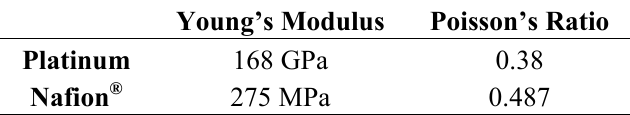
Table 1. The physical